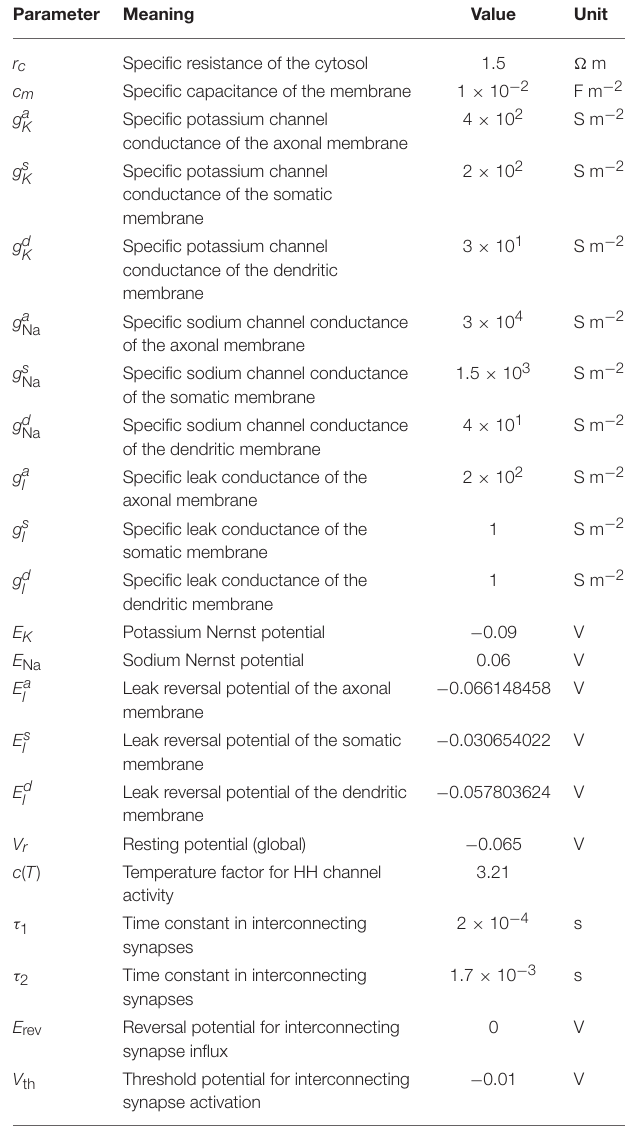
TABLE 4 | Parameters for the large-scale network